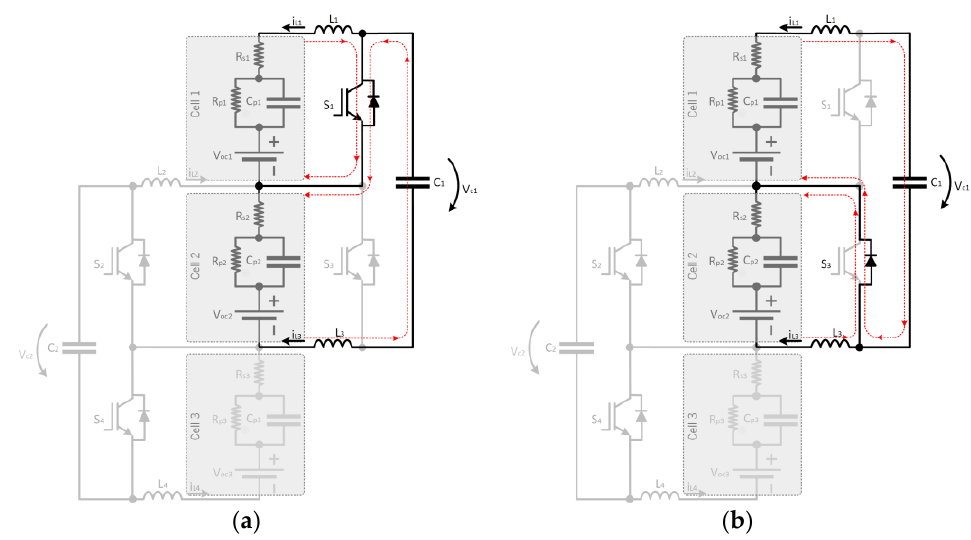
Figure 16. Operating modes of the Cuk converter: (a) discharging of cell 1; ( b ) charging of cell 2.